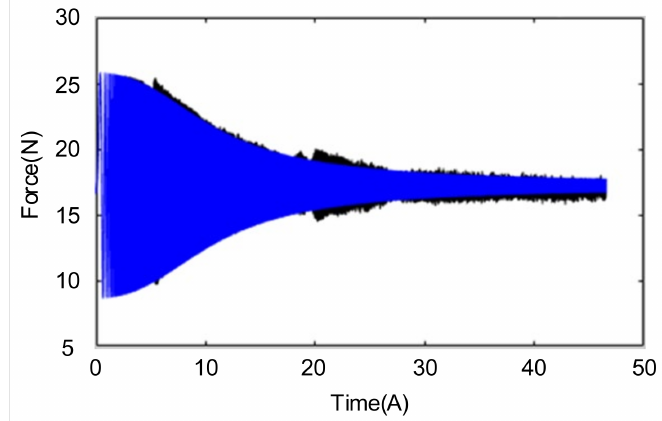
Figure 5. Comparison of the original force data (black) and fitted model (blue).